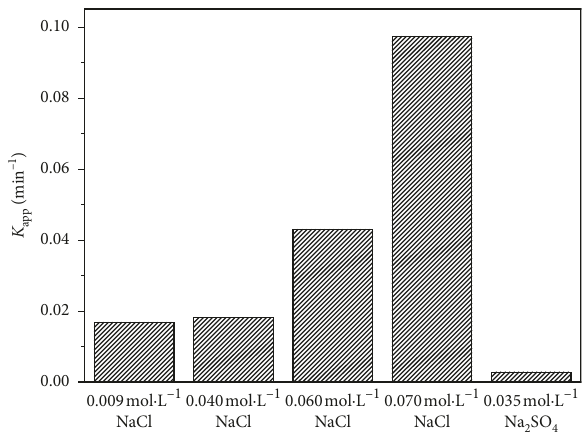
Figure 4: Effect of NaCl and Na 2 SO 4 , as well as NaCl concentration on K app values. Conditions: current density, 5.4 mA · cm − 2 ; [Rh-B], 80mg · L − 1 ; T , 25 ° C; flow rate, 30L · h − 1